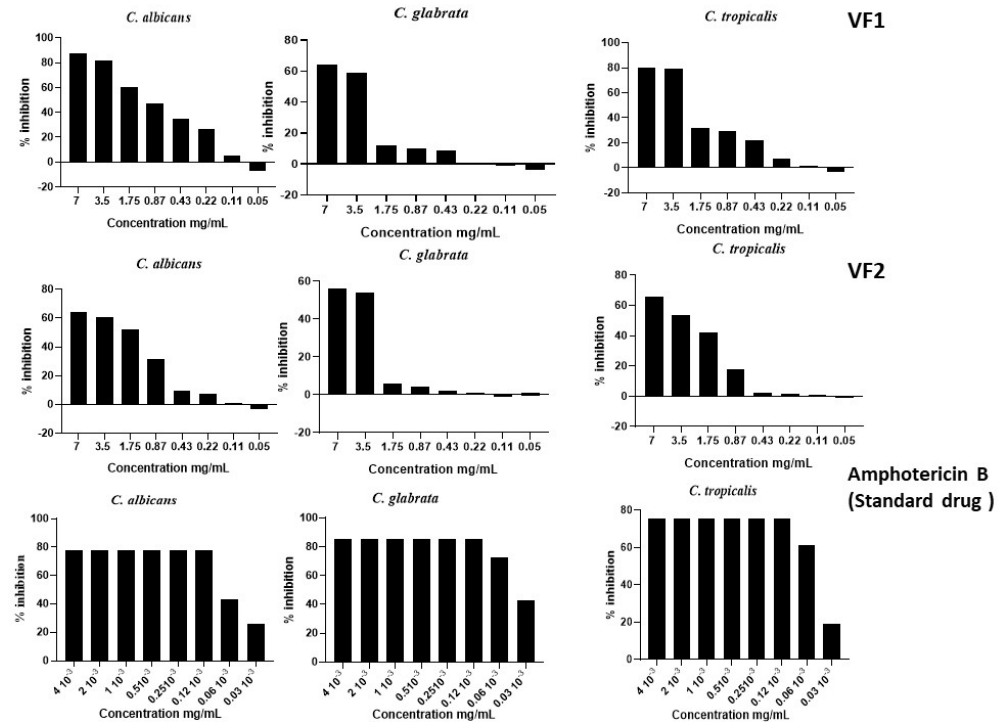
Figure 6. Effect of different concentrations of VFs on the biofilm of Candida spp. (BSI).